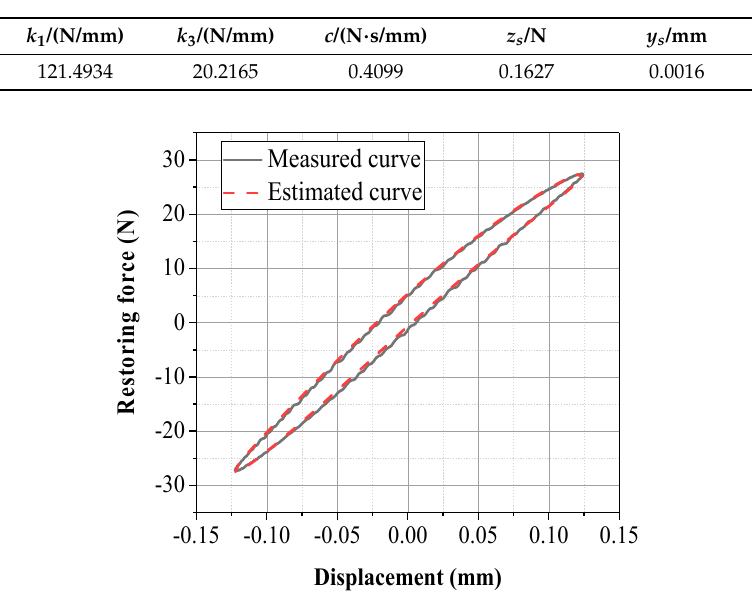
Table 3. Identification result (vibration amplitude = 0.350 mm, frequency = 10 Hz).